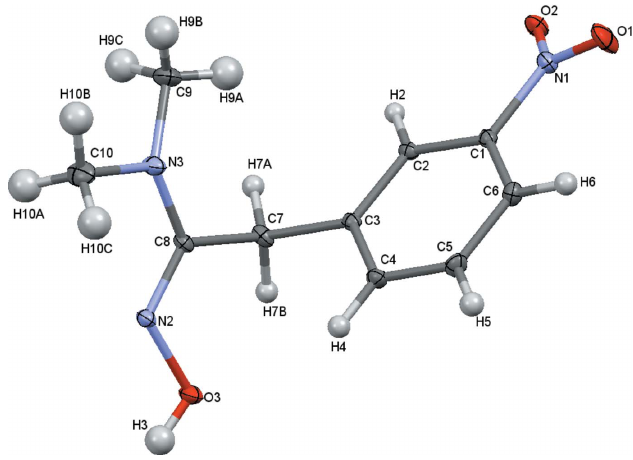
Figure 1 The molecular structure of the title compound, with displacement ellipsoids drawn at the 50% probability